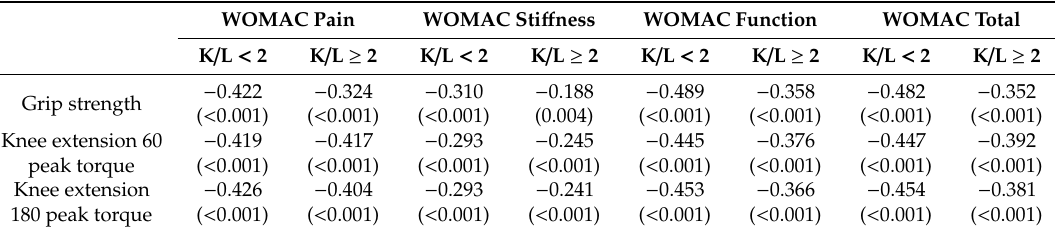
Table 2. Correlation analysis between WOMAC and muscle strength measured by grip strength and knee extensor